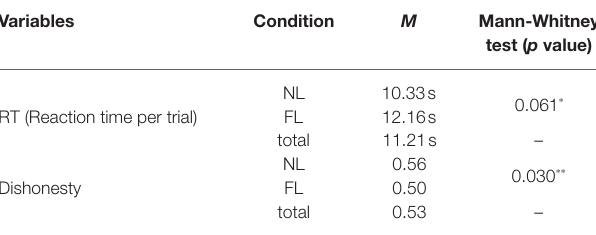
TABLE 4 | Mean reaction time and dishonesty of participants.